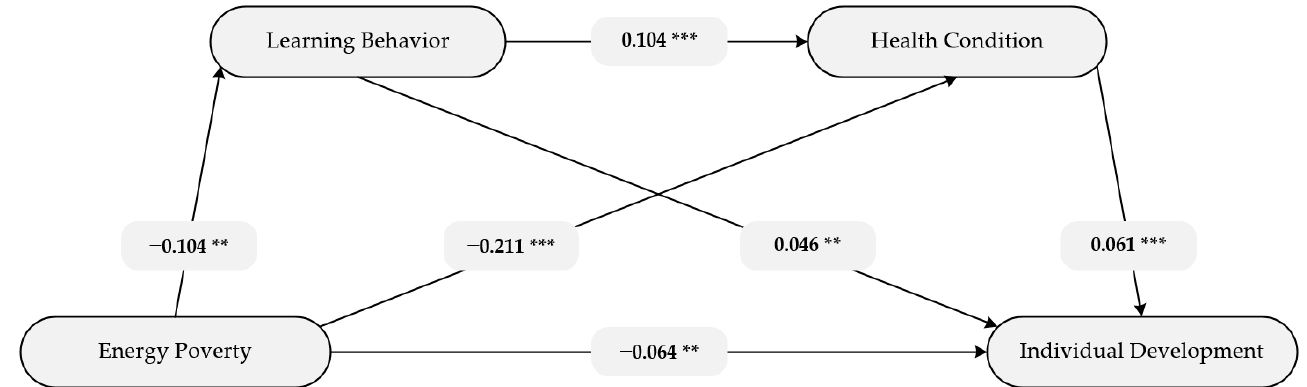
Figure 2. Overall pathways and coefficient. Note. ** p < 0.01, *** p <